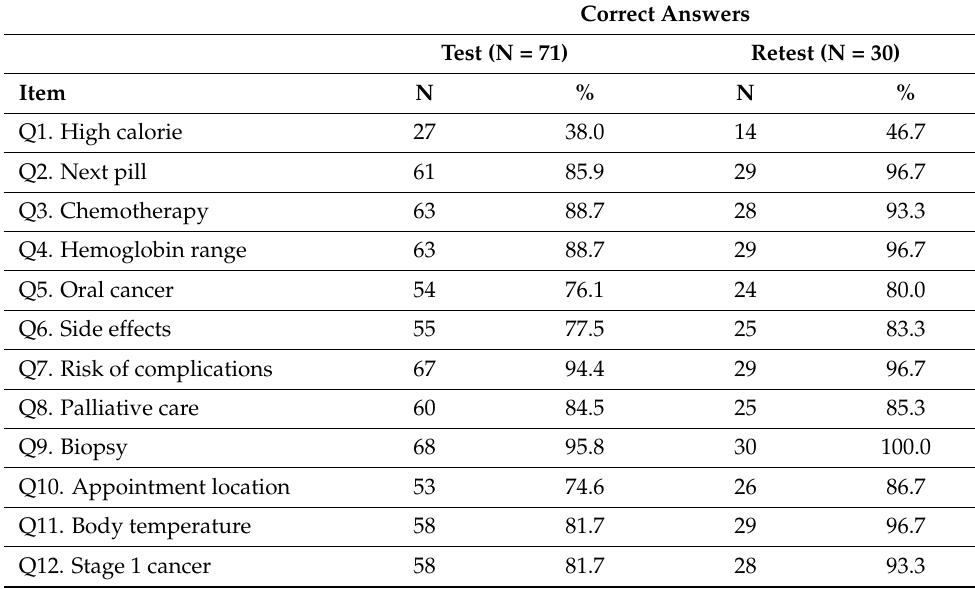
Table 3. Questionnaire items—correct